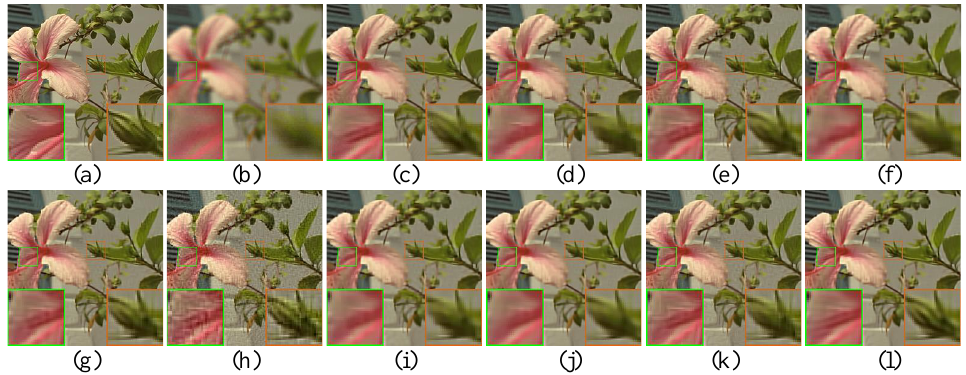
Figure 5. Visual comparison of Lily by image deblurring with uniform kernel. ( a ) Original image; √ ( b ) noisy and blurred image (9 × 9 uniform kernel, σ n = 2); ( c ) BM3D [70] (PSNR = 28.58 dB, SSIM = 0.8119); ( d ) L0-ABS [71] (PSNR = 28.05 dB, SSIM = 0.8004); ( e ) ASDS [59] (PSNR = 29.21 dB, SSIM = 0.8290); ( f ) EPLL [72] (PSNR = 27.04 dB, SSIM = 0.7981); ( g ) NCSR [6] (PSNR = 29.39 dB, SSIM = 0.8393); ( h ) JSM [7] (PSNR = 26.97 dB, SSIM = 0.6924); ( i ) L2-r-L0 [73] (PSNR = 28.47 dB, SSIM = 0.8155); ( j ) WNNM [40] (PSNR = 29.25 dB, SSIM = 0.8406); ( k ) NLNCDR [74] (PSNR = 28.69 dB, SSIM = 0.8039); ( l ) SPG-SC (PSNR = 29.40 dB , SSIM = 0.8476 ). Table 3. PSNR (dB) comparison of BM3D [70], L0-ABS [71], ASDS [59], EPLL [72], NCSR [6], JSM